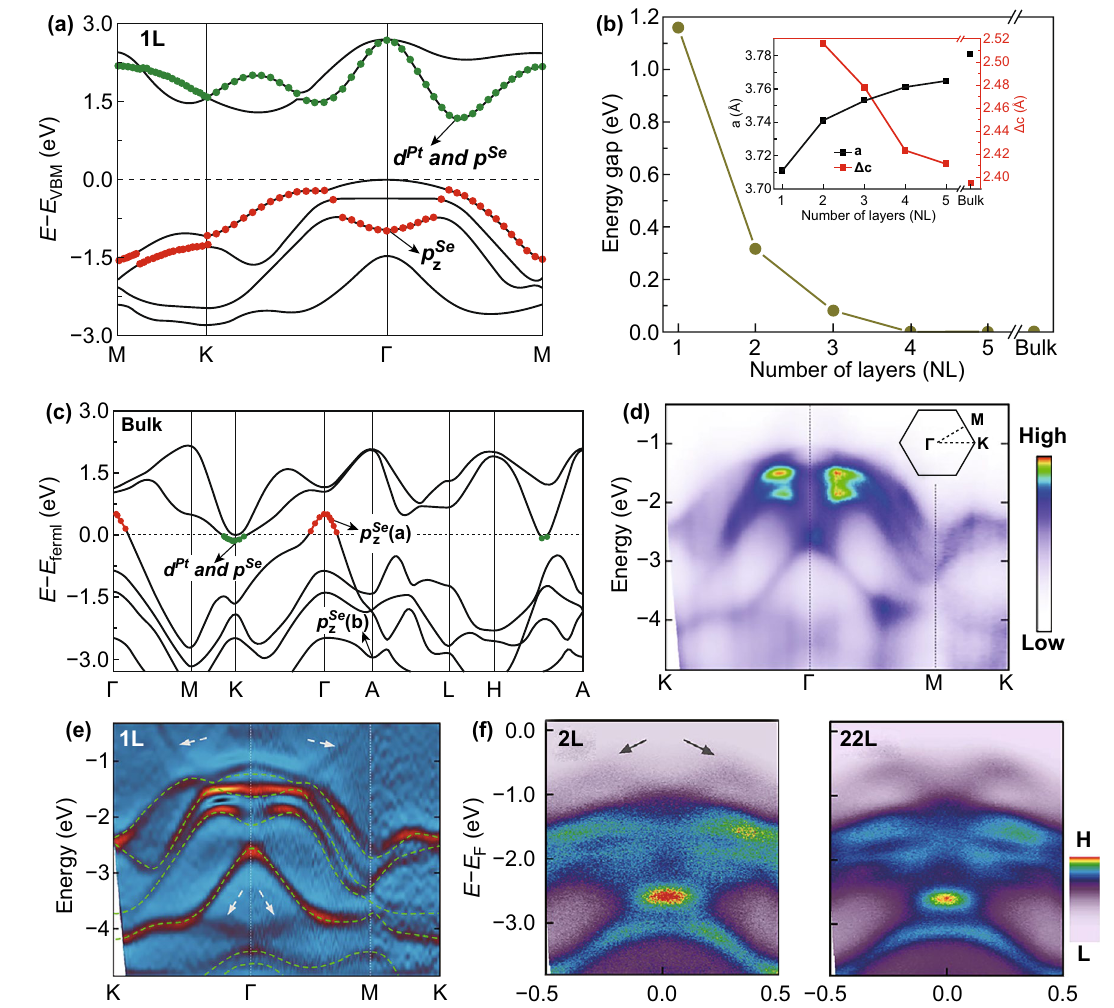
Fig. 2 Electronic structure of PtSe 2 . a Band structure of monolayer PtSe 2 . Reproduced with permission [28]. Copyright 2018, John Wiley and Sons. b Energy gap evolution as a function of number of layers (NL) for PtSe 2 . Inset: layer dependence of lattice constant versus NL. Repro‑ duced with permission [27]. Copyright 2019, Elsevier. c Band structure of bulk PtSe 2 . Reproduced with permission [28]. Copyright 2018, John Wiley and Sons. d ARPES spectra and e corresponding second derivative spectra of monolayer PtSe 2 . Reproduced with permission [25]. Copy‑ right 2015, American Chemical Society. f ARPES spectra of bilayer and 22‑L PtSe 2 . Reproduced with permission [43]. Copyright 2015, Ameri‑ can Chemical